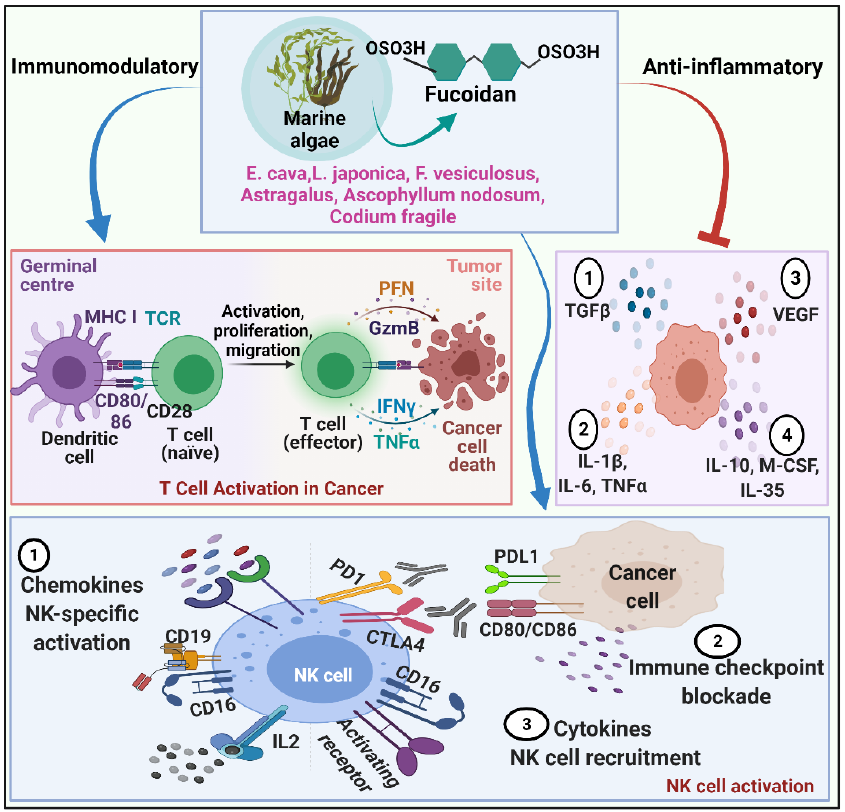
Figure 2. Depicts immunomodulatory features of fucoidan serve as a potential approach to managing cancer metastasis. Fucoidan from marine algae enhances immune cell proliferation, activation and migration. Fucoidan significantly acti- vates NK cells and recruits them into the tumor microenvironment. It also stimulates dendritic cells to activate T cells and modulates immune responses against tumor cells. Fucoidan illustrates anti-inflammatory effects by suppressing the se- cretion of proinflammatory mediators at the tumor site.